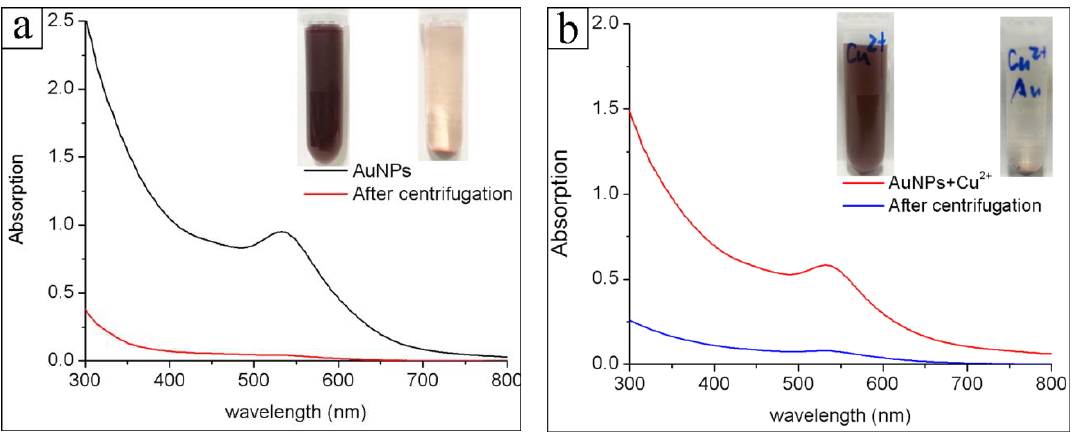
Figure 2. ( a ) UV-Vis absorption spectra of the proanthocyanidin-functionalized gold nanoparticles solution before and after centrifugation; ( b ) UV-Vis absorption spectra of the proanthocyanidin-functionalized gold nanoparticles redispersed in the 20 mg/L CuCl 2 solution before and after centrifugation. Figure 3 shows the FTIR spectrum of the pure proanthocyanidins and